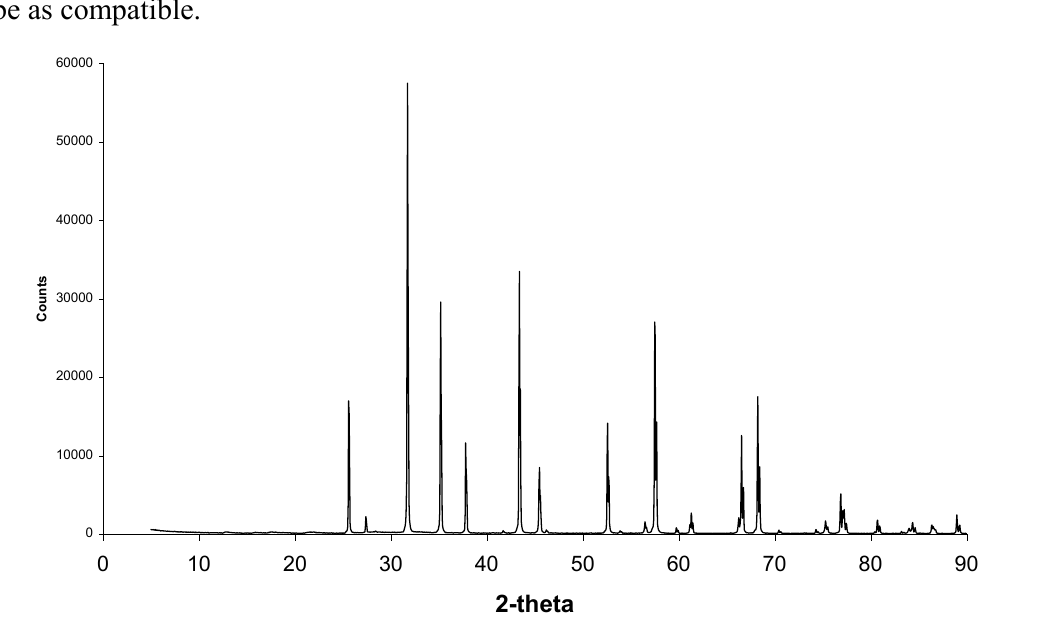
Figure 7. XRD scan of alumina after SBF coating showing corundum peaks and halite